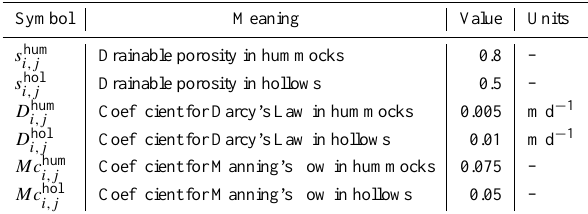
Table 1. Values for heterogeneous parameters in hummocks and